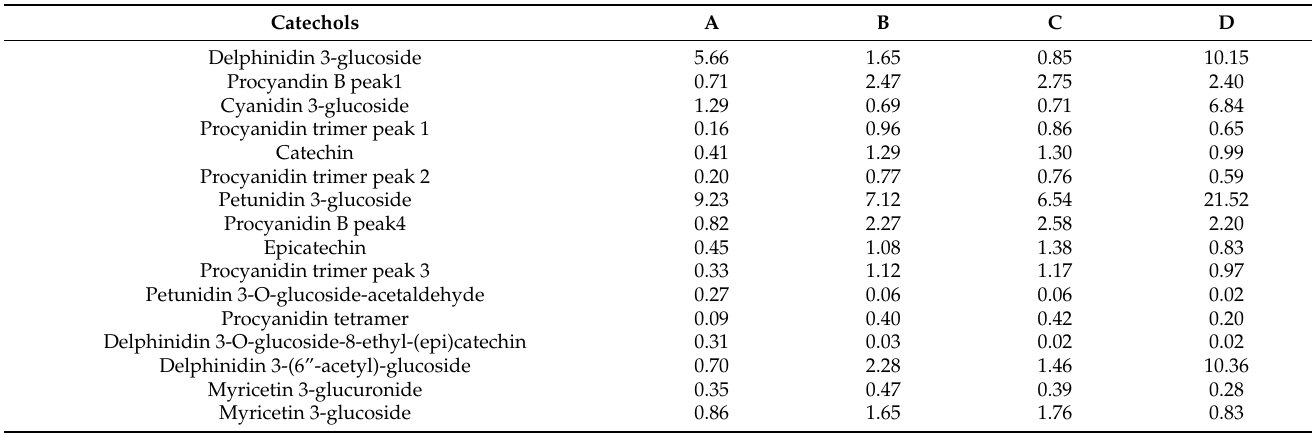
Figure 9. Nrf2 activation by enocianinas. Values are reported as fold increase with respect to control cells. The left panel shows the dose-dependent activity of the four enocianinas in a concentration range between 100 and 250 µ g/mL. The right panel shows the one-way ANOVA analysis followed by multi-comparison test for the data relative to the 250 µ g/mL concentration. Significances observed for the 250 µ g/mL were also observed for the dose of 200 µ g/mL (** p < 0.01, *** p < 0.005, **** p < 0.0001). Table 5. Relative amount calculated with respect to the IS of each compound in enocianina containing the catechol moiety and catechol index as a sum of the relative amount of each catechol com- pound.